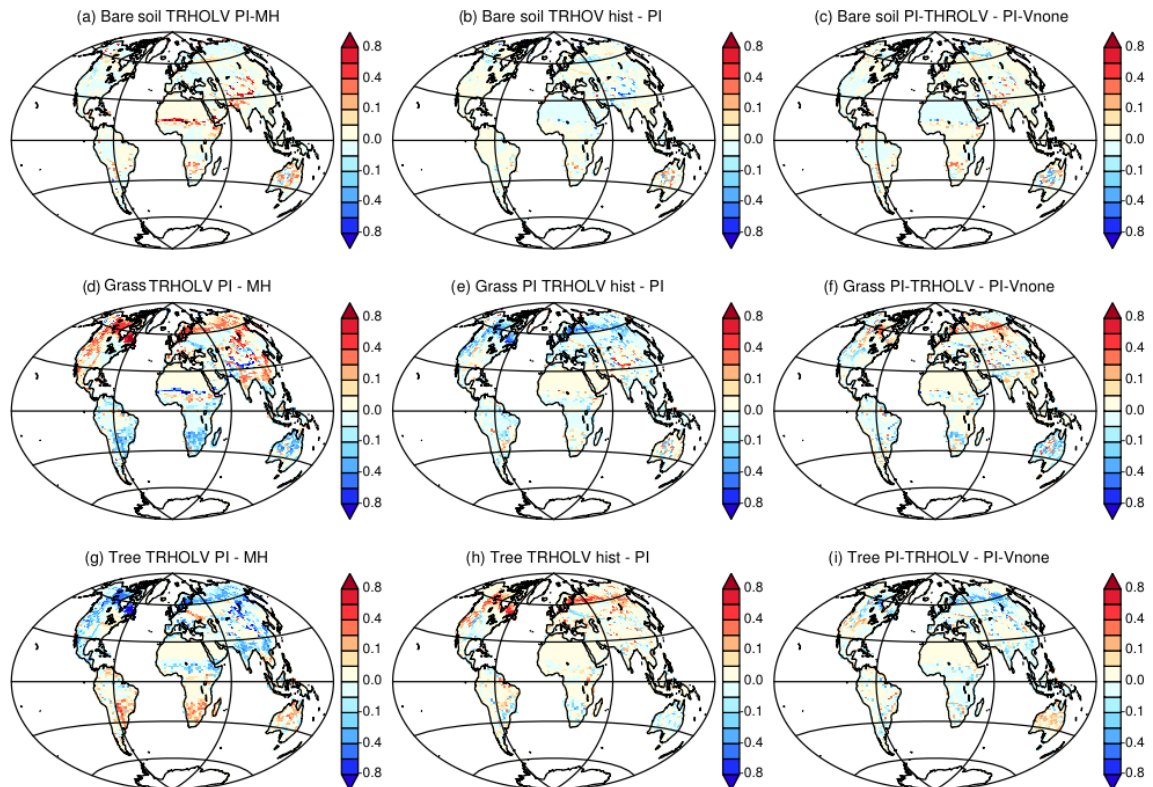
Figure 10. Vegetation map comparing (a, d, g) the Mid-Holocene (first 50 years) and the preindustrial (50 years around 1850CE (150 to 100BP)) periods of the transient simulation, (b, d, h) the differences between the historical period (last 50 years) and the preindustrial period of the transient simulation, and (c, f, i) the difference between preindustrial climate for the transient simulation and the PI-Vnone simulations. For simplicity we only consider bare soil (a–c) , grass (d–f) , and trees (g–i)